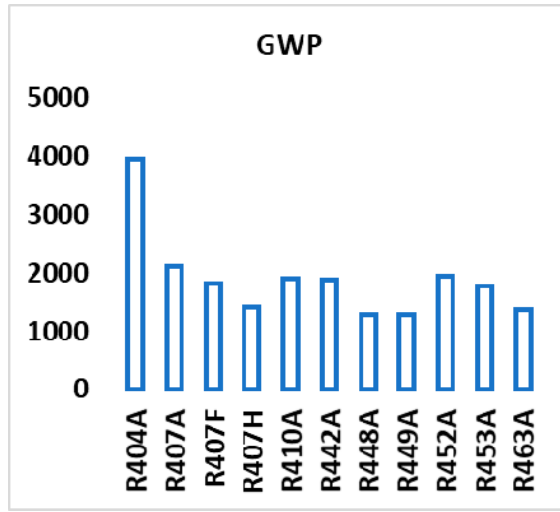
Figure 9. GWP of all refrigerants.